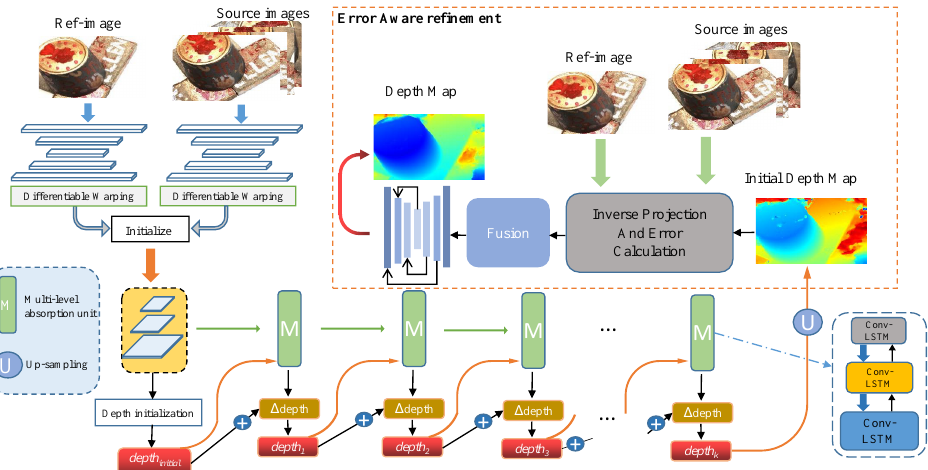
Figure 3. EMO-MVS architecture. EMO-MVS first extracts features via an FPN. Then, the initial- ization depth ( depth initial ) is obtained by using the initialization module, and the iterative variable optimizer optimizes the initialization depth ( depth initial ). Inside the iterative variable optimizer, we use multilevel absorption units to aggregate the multiscale information, and after several optimiza- tion iterations, we obtain the initial depth map. Finally, we input the initial depth map into our error-aware enhancement module to obtain the final depth